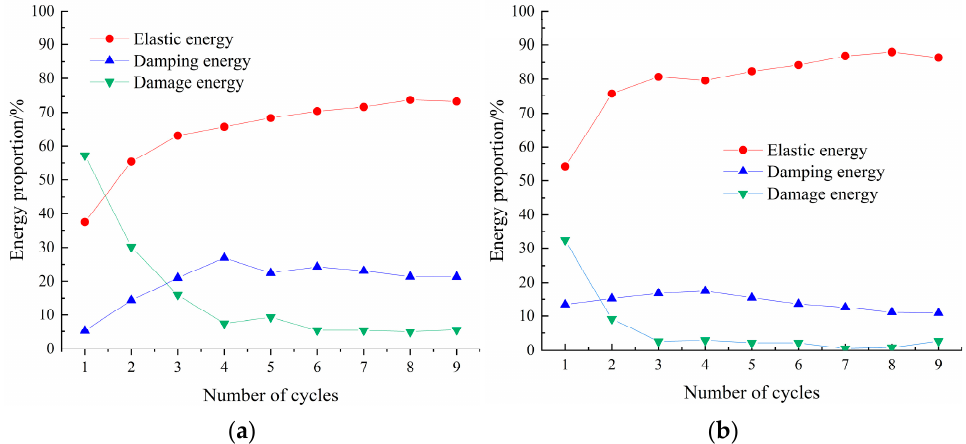
Figure 15. The evolution of rock energy proportion under CLLCL. ( a ) Sandstone; ( b ) granite.